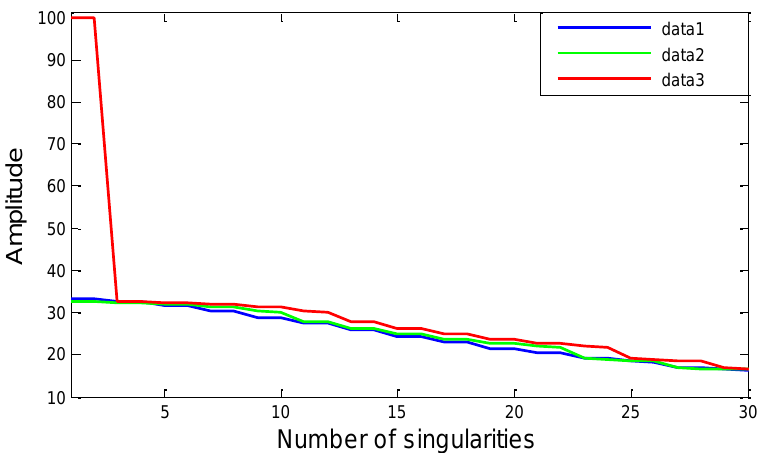
Figure 1. Characteristic curves of the singular values of an original partial discharge (PD) signal (data 1); the PD signal with added Gaussian white noise (data 2); and the PD signal with added periodic narrowband noise (data 3).